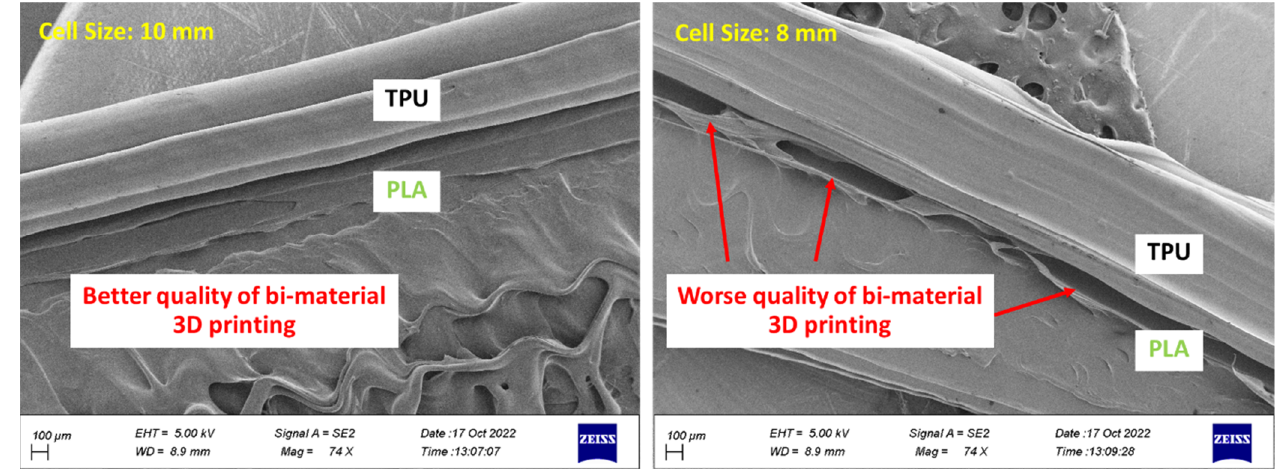
Figure 20. The effect of cell size on the adhesion of two PLA/TPU layers.